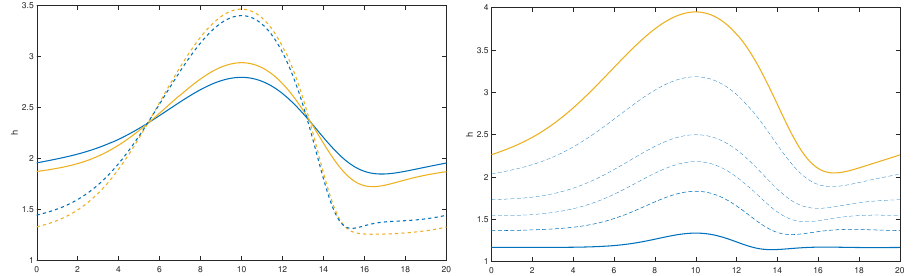
Figure 4. The left panel illustrates the difference in the maximal height of the traveling waves for the laminar model (solid lines: blue corresponds to a 1 = 0.1, b = 11 and yellow corresponds to a 1 = 1.5, b = 13) and for the plug flow model (dashed lines: blue corresponds to a = 0.2, b = 10, c = 1 and yellow corresponds to a = 0.4, b = 12, c = 3) using h 0 = 2.29 in both models. The right panel shows the variation of the shape of the traveling wave for different h 0 values as it ranges from 1.2 to 3.0 for fixed values of a 1 = 1 and b = 11 in the laminar flow model. The non-dimensional velocity of the traveling wave increases from 0.17 to 2.23 as h 0 increases.